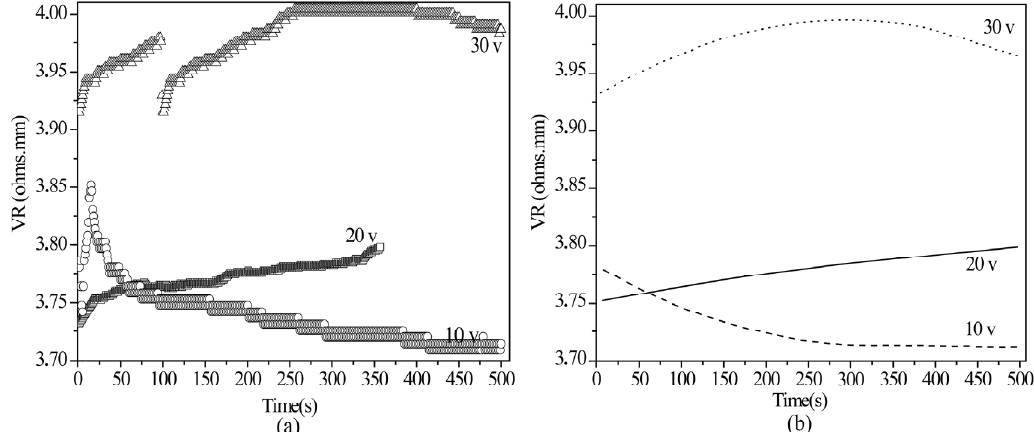
Figure 9. ( a ) Volume resistivity and ( b ) polynomial fit of volume resistivity of sample C in real time under applied voltages of 10, 20, and 30